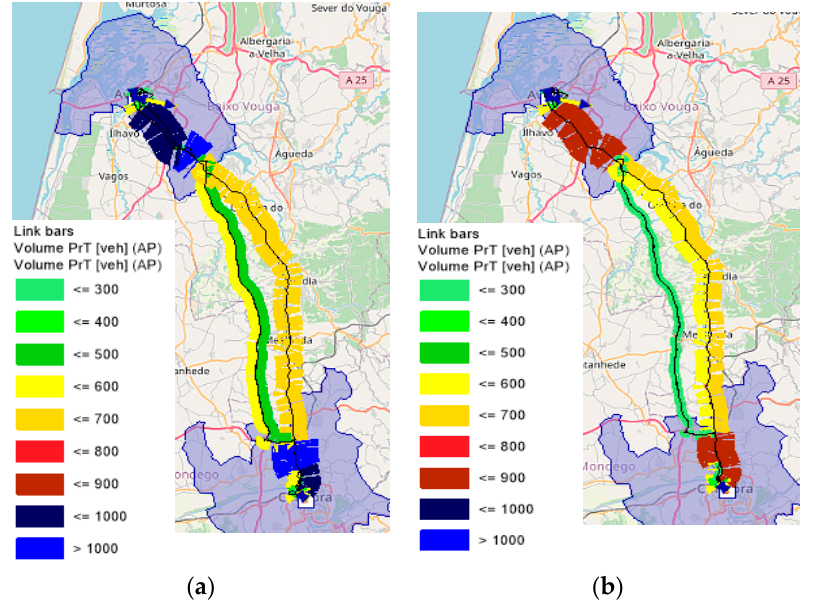
Figure 6. Representation of the number of vehicles in the network: ( a ) baseline scenario and ( b ) off-peak scenario.